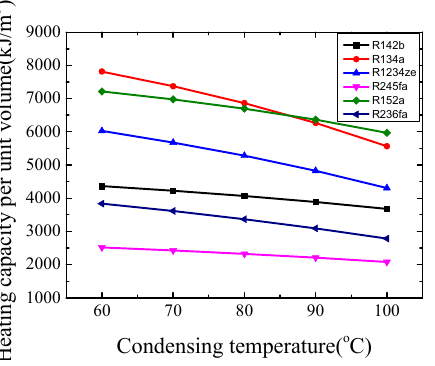
Figure 4. Comparison of heating capacity per unit volume among different refrigerants.